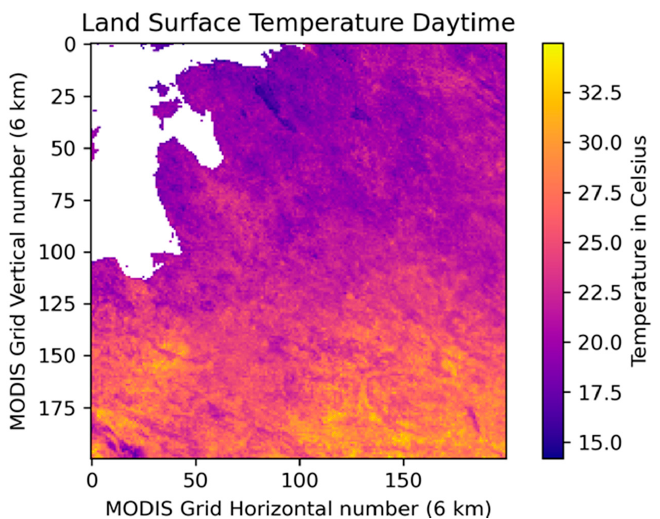
Figure 1. Example of a moderate resolution imaging spectroradiometer (MODIS) scene from the middle-east region in Europe. Pixel ground size is 6